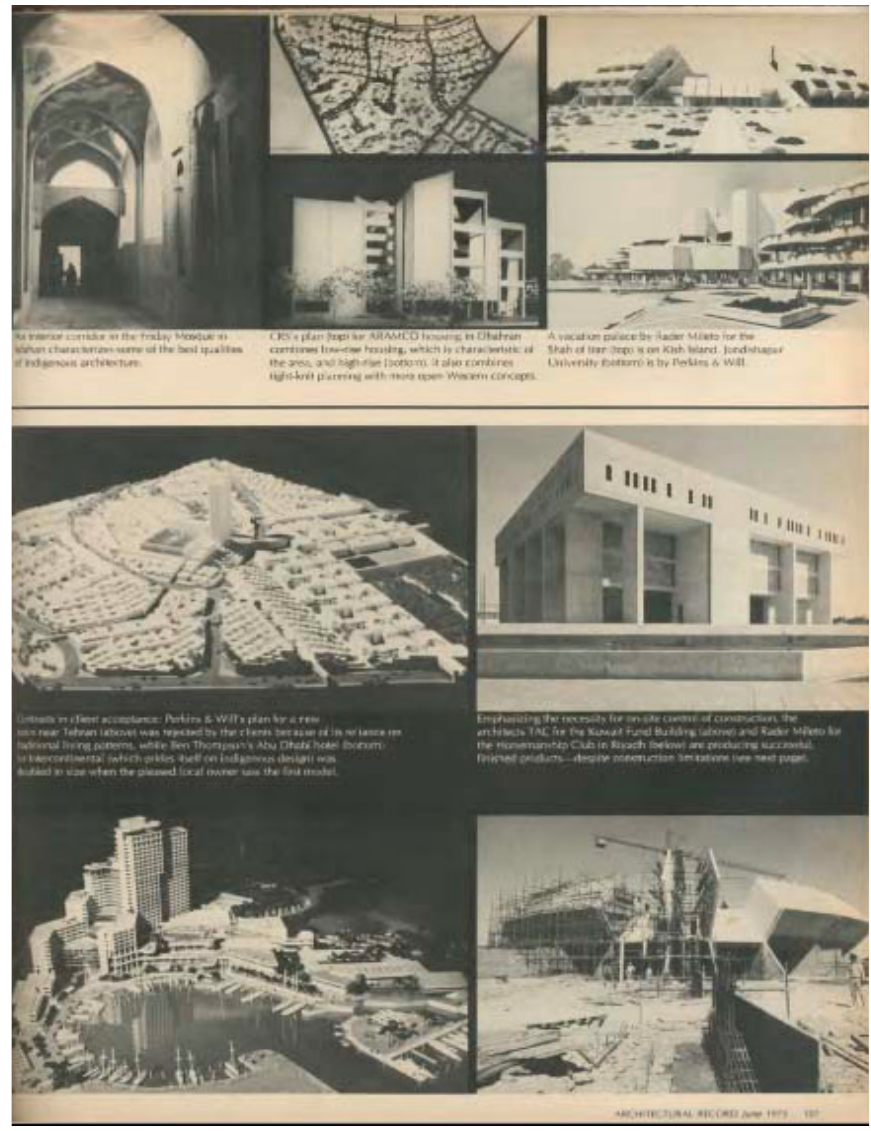
Urban development projects in Kuwait and Saudi Arabia